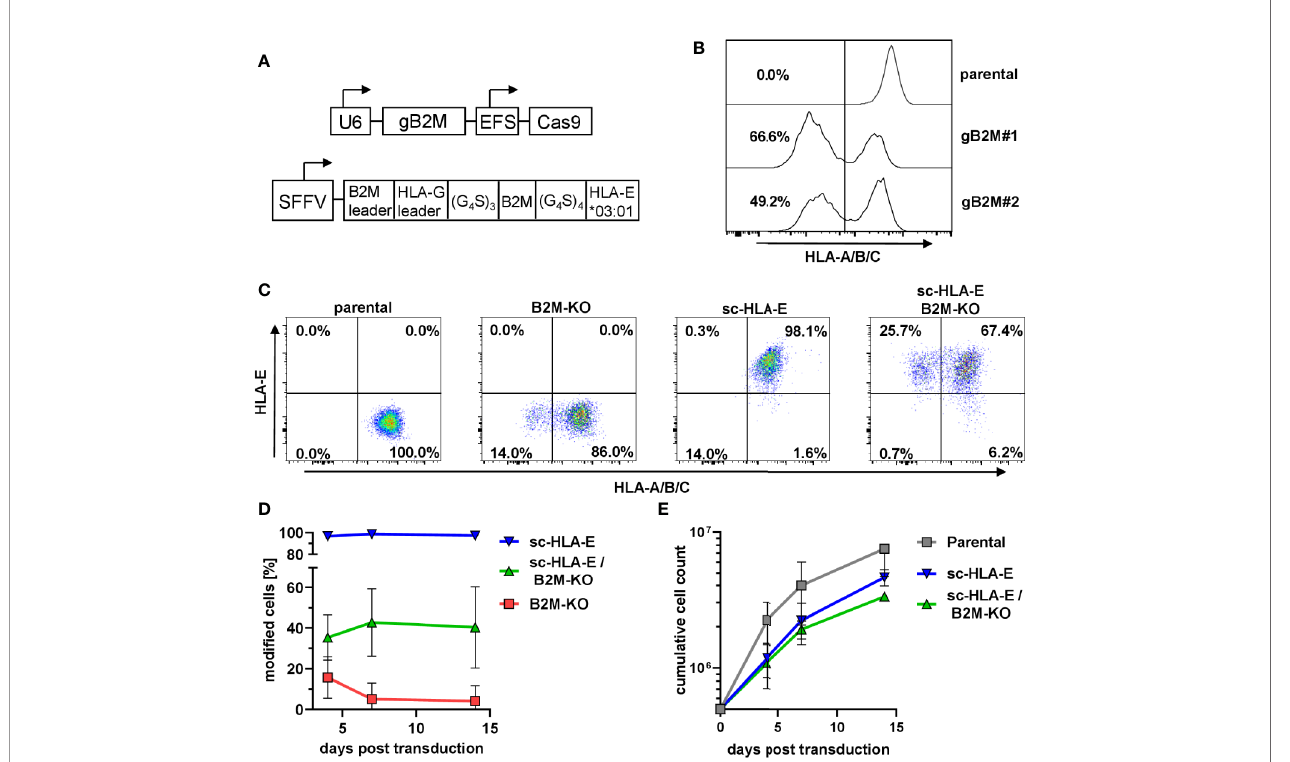
FIGURE 1 | Knockout of B2M and simultaneous overexpression of sc-HLA-E in primary NK cells (A) Outline of the lentiviral expression cassettes used for CRISPR/ Cas9 mediated B2M-knockout and expression of the sc-HLA-E molecule. Cas9 and gB2M are expressed from the same lentiviral vector, driven by an EFS and an U6 promoter, respectively. The HLA-E*03:01 heavy chain is linked to B2M and the HLA-G leader peptide by G 4 S linkers and expression is driven from an SFFV promoter. (B) Knockout of B2M in SKM1 cells abrogates surface expression of HLA class I detected via fl ow cytometry on day 10 after transduction. (C) Frequencies of HLA class I and sc-HLA-E expressing primary NK cells 4 days after transduction with lentiviral particles encoding gB2M and Cas9, sc-HLA-E or a combination of both compared to an untransduced control. (D) Frequencies of modi fi ed cells measured on day 4, 7 and 14 after transduction (mean ± SD; n = 6 for sc-HLA-E, n = 5 for sc-HLA-E/B2M-KO and B2M-KO). (E) Growth of NK cell cultures measured 4, 7 and 14 days after transduction. Shown is the cumulative cell count of all NK cells within the culture. The NK cells showed a fold-expansion from the day of transduction of 15.2 ± 5.72 for parental, 9.36 ± 1.29 for sc-HLA-E and 6.74 ± 0.31 for sc-HLA-E/B2M-KO NK cells (mean ± SD; n =